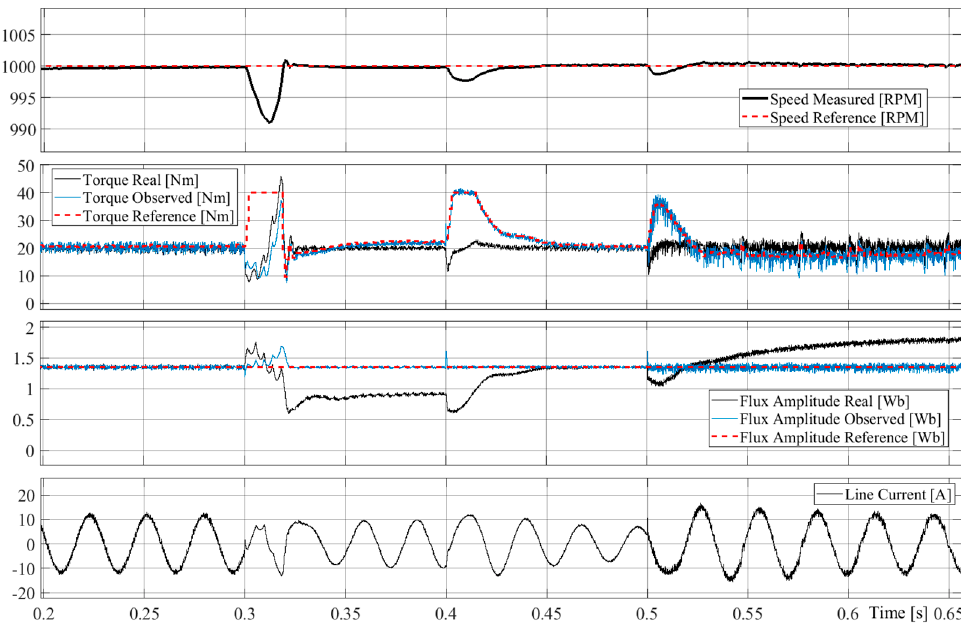
Figure 9. Online change of the winding topology—motor/predictive torque control (PTC): delta/delta (0.2–0.3 s), star/delta (0.3–0.4 s), star/star (0.4–0.5 s), delta/star (0.5–0.65 s).